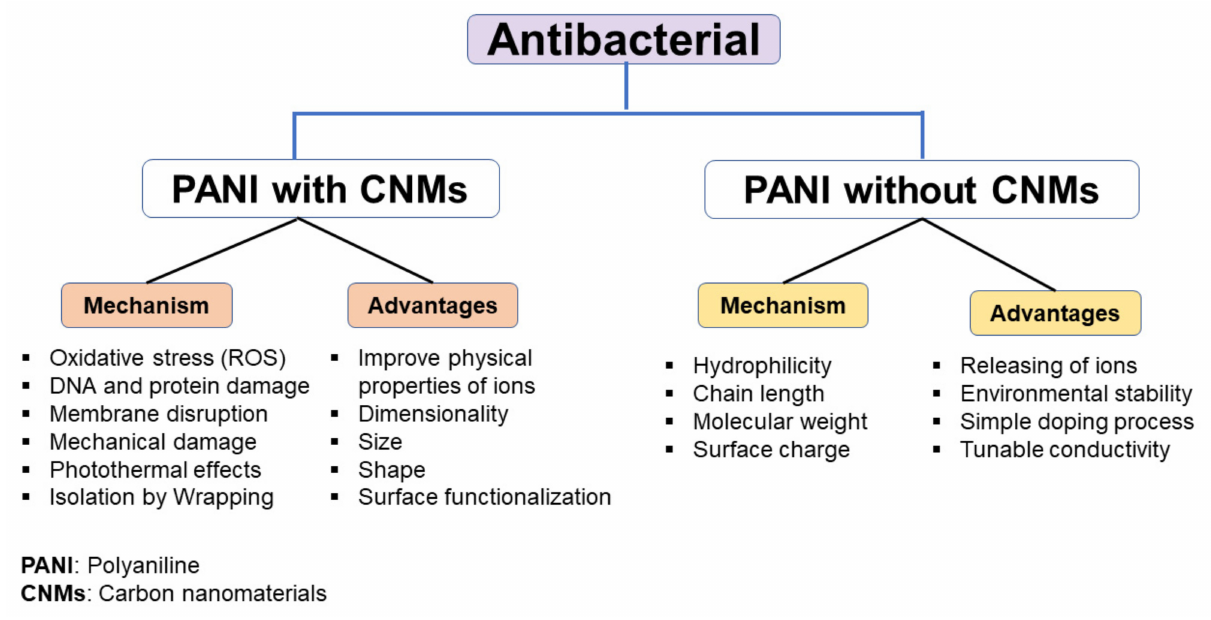
Figure 6. The advantages and mechanisms of the PANI composites with and without